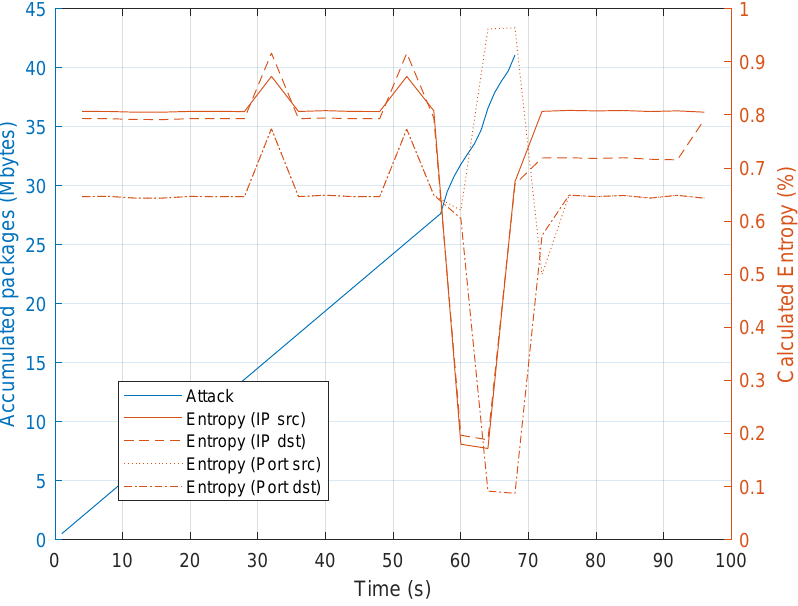
Figure 7. Entropy variation for a DoS flooding with spoofed src port attack in Internet of Things